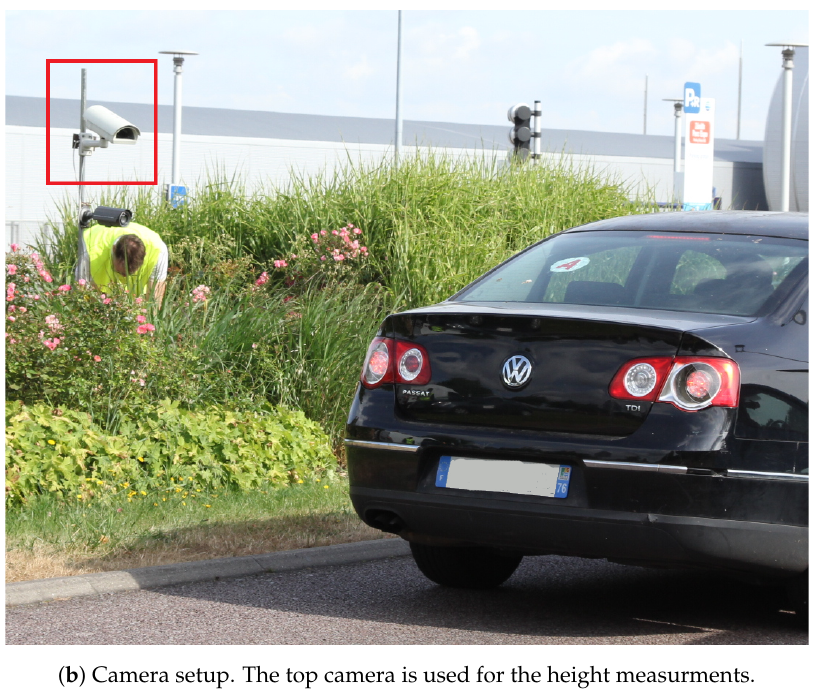
Figure 4. Camera installation used in the